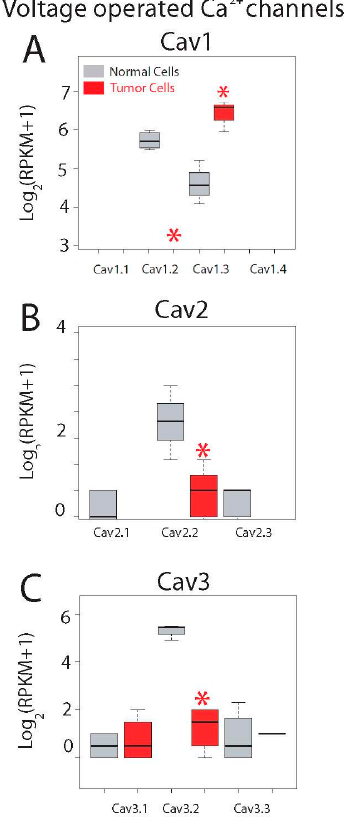
Figure 7. Expression of voltage-gated Ca 2+ channels in normal and colon cancer cells. Expression levels of Cav1s ( A ), Cav2s ( B ) and Cav3s ( C ) in normal colonic cells (grey bars) and colon cancer cells (red bars). * p statistically significant by three independent methods.